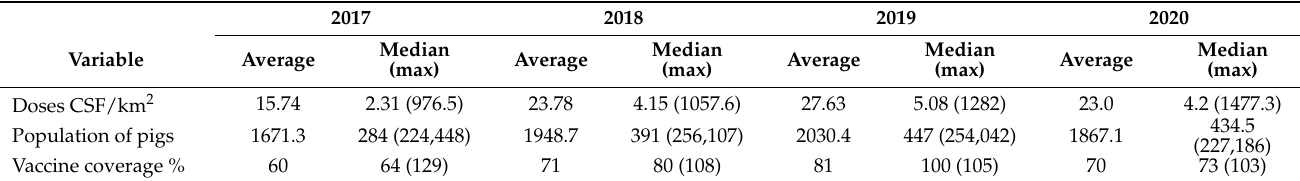
Table 5. Centrality measures of model variables (fixed effects) aggregated by parish distribution in